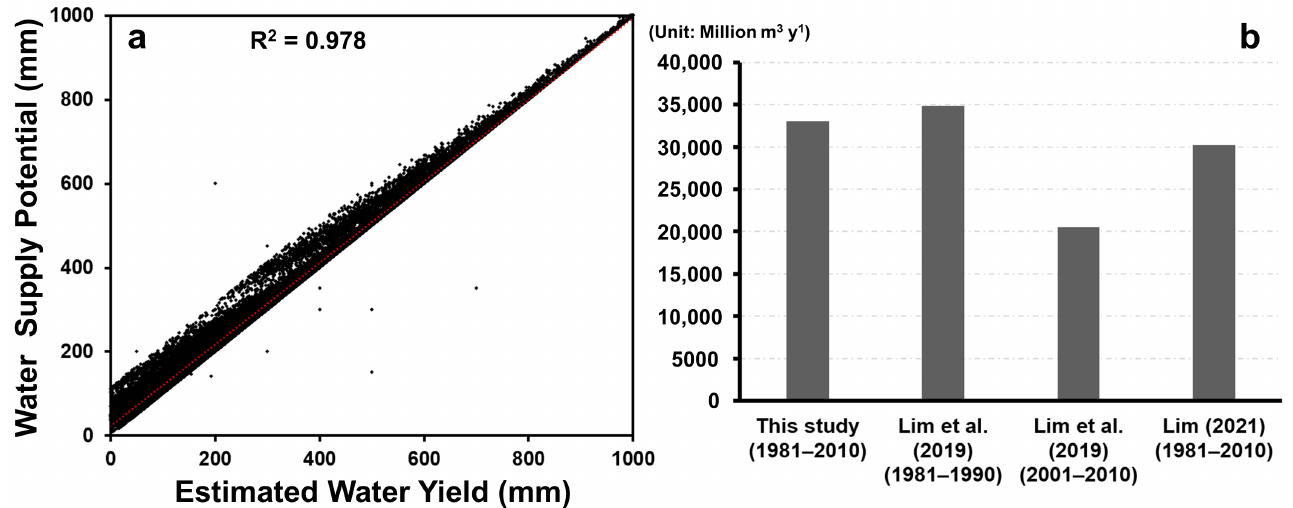
Figure 2. Evaluation of model performance ( a ): statistical evaluation with WSP, ( b ): quantitative comparison with previously reported models.